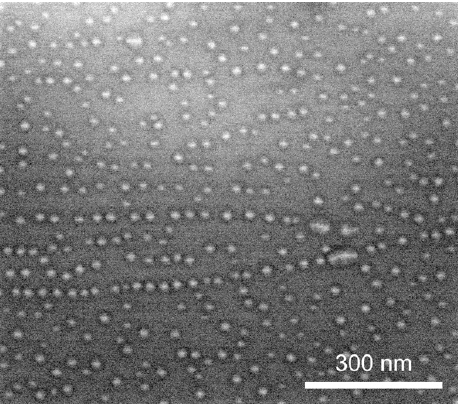
3 of 9 Figure 1. Schematic representation of a typical PL structure in which the LT-GaAs capping layer differs in the thickness and the arsenic pressure provided during the growth. The reference sample was studied in FEI Nova Nanolab scanning electron micro- scope (SEM) and NT-MDT Ntegra atomic force microscope (AFM) for the characterization of shape, size and surface density of uncovered QDs. For PL studies, the samples were placed in a flow Janis ST-500 cryostat to control the sample temperature ( T PL ) in the range of 77–300 K. The PL was excited by a YLF:Nd +3 laser operating in the cw mode ( λ = 527 nm). The laser power was varied in the range from 0.084 to 40 mW. PL signal was detected using an SOL instrument’s MS 5204i monochrom- ator and a single-channel InGaAs detector using synchronous detection (SRS 830 Stanford Research Systems). 3. Results and Discussion The QD growth conditions were chosen so that the surface density of QDs was suffi- ciently large to provide high PL intensity, but not too large to stimulate QD coalescence. It is commonly known that InAs dots arranged quite close to each other merge due to